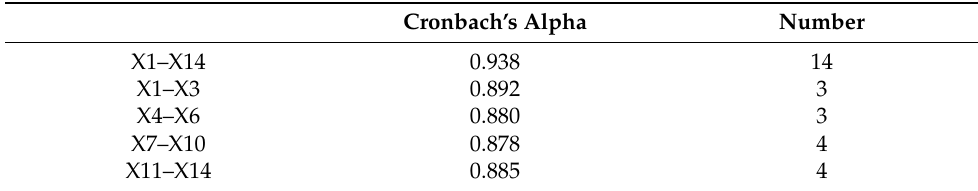
Table 4. Reliability statistics results.